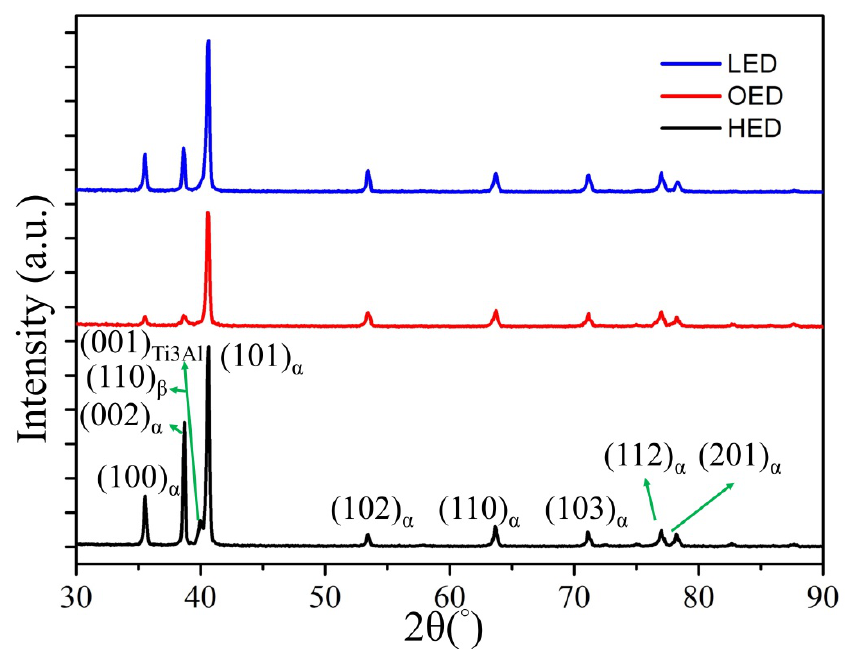
Figure 4. The X- ray diffraction spectrum of HED, LED and OED built samples. The α -Ti6Al4V characteristic (100), (002) and (101) and β -Ti6Al4V characteristic (110) peaks were observed in all samples. The characteristic peaks of α phase are overlapped with α′ martensitic phase only in LED built sample. Minor Ti 3 Al phase of its characteristic peak (110) was observed only in HED built sample.